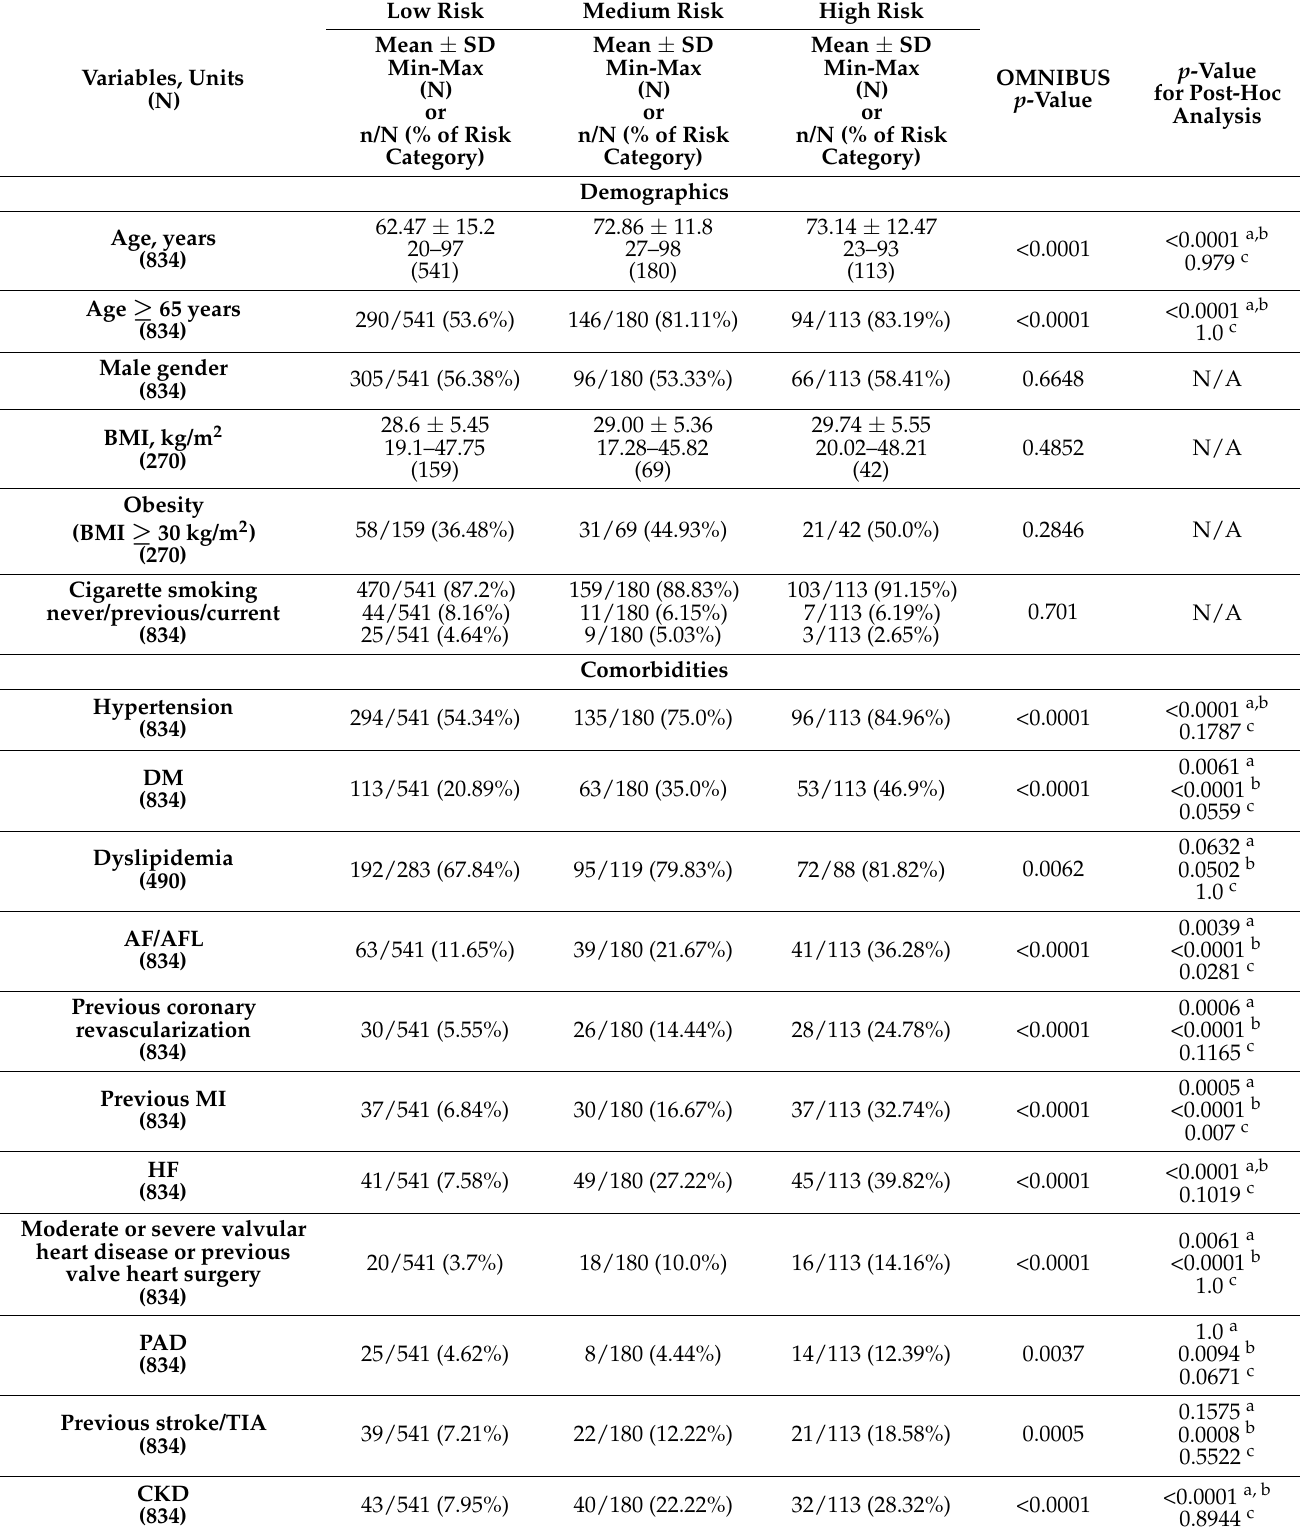
Table 1. Baseline characteristics of the study cohort after GRAM risk